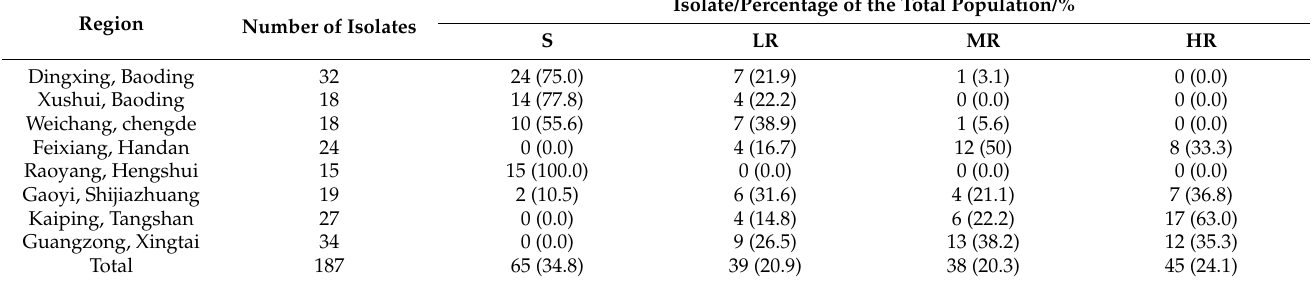
Table 3. Resistance level (S = sensitive; LR = low resistance, MR = moderate resistance, or HR = high resistance) to penthiopyrad of 187 Botrytis cinerea isolates sampled from tomato plants affected by gray mold and treated with SDHI fungicides cropped in eight regions of Hebei Province (China), during 2021–2022.